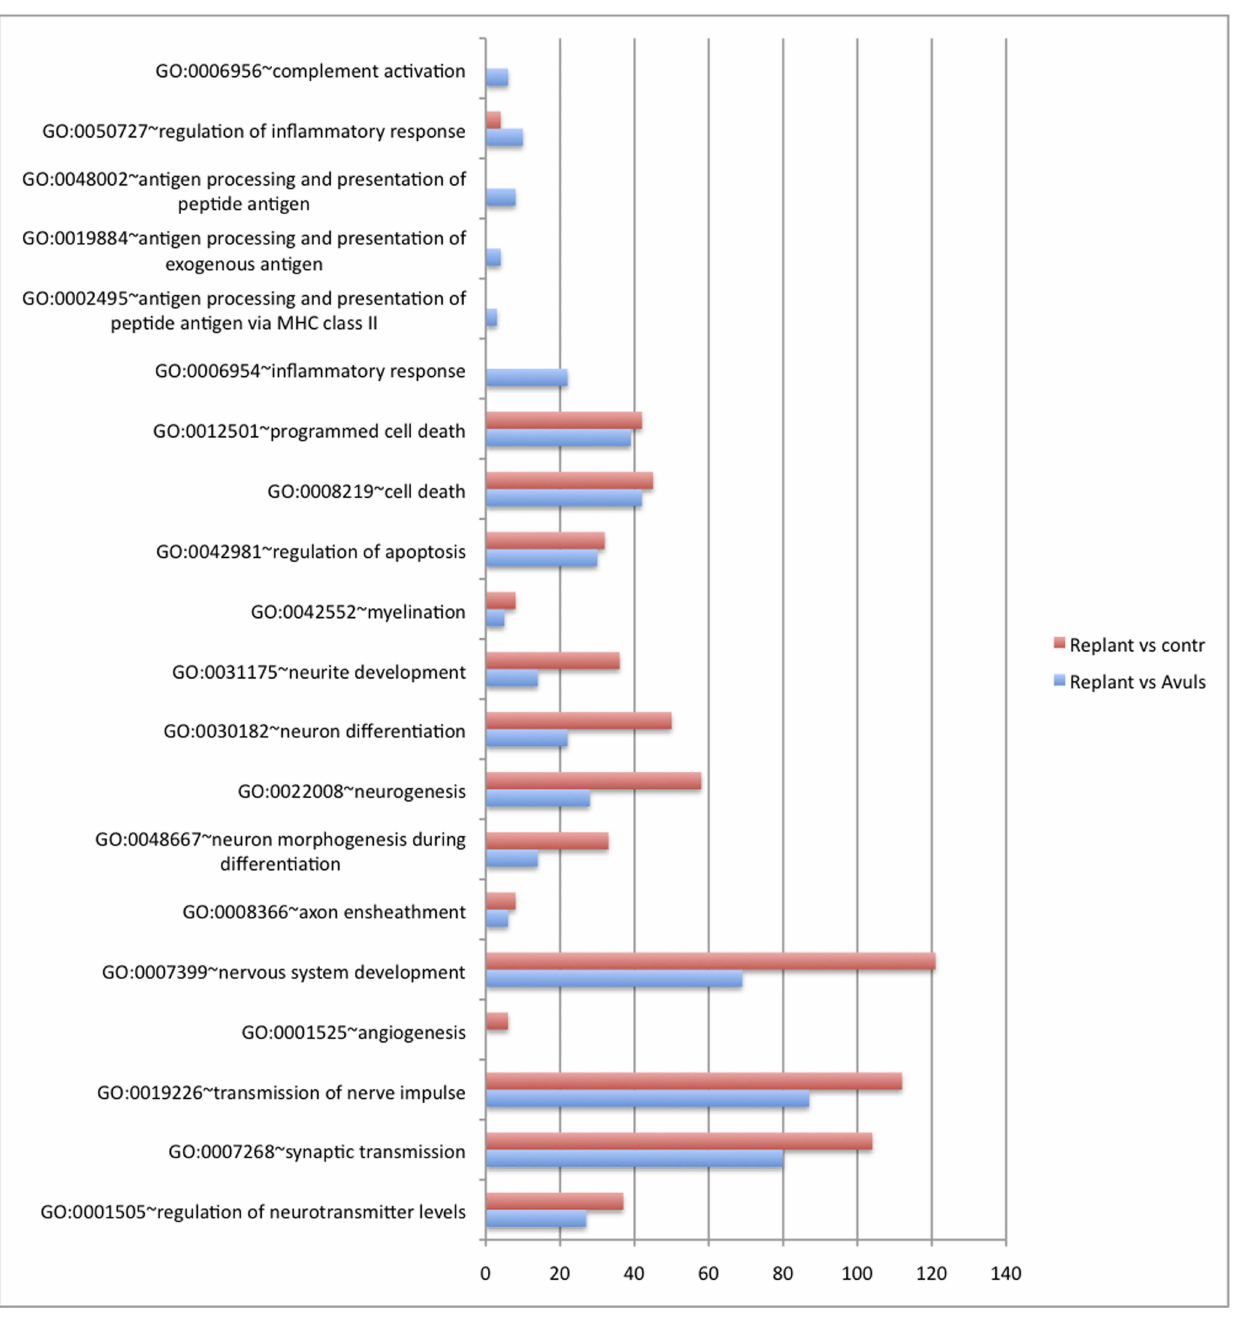
Figure 2 | A diagram illustrating the number of significantly regulated genes in selected categories after avulsion and avulsion plus replantation. The x -axis indicates the number of genes that have undergone significant changes in expression. Note that this number includes both up- and down-